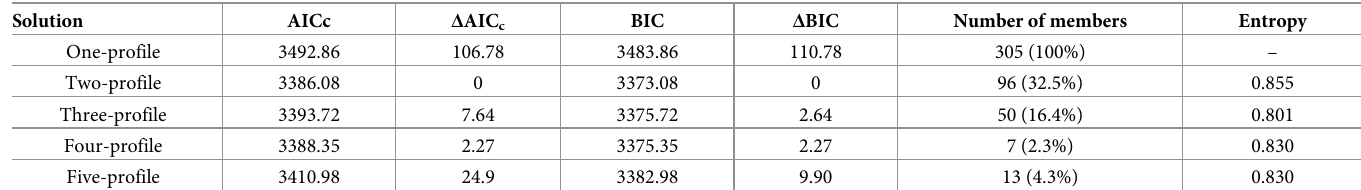
Table 5. Model fit and entropy statistics for 1 to 5 profiles solutions (N =